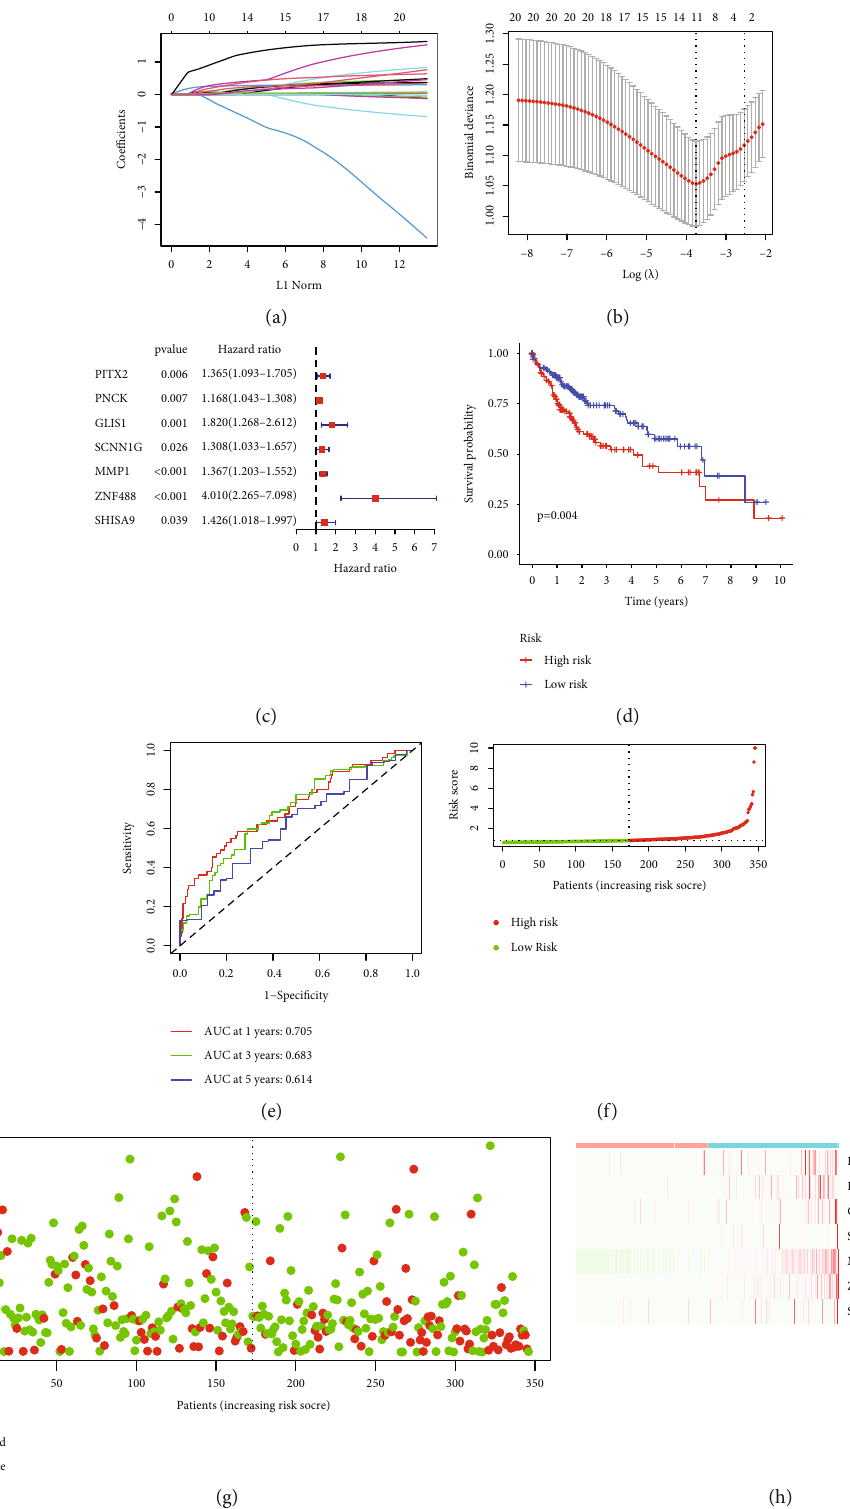
Figure 3: Establishment of a stage-related gene signature in TCGA datasets. (a) Distribution of LASSO coe ffi cients of the 21 stage-related genes. (b) The generated coe ffi cient distribution plots for the logarithmic (lambda) sequence for the selection of the best parameter (lambda). (c) Univariate assays con fi rmed 7 genes as critical prognostic genes, including PITX2, PNCK, GLIS1, SCNN1G, MMP1, ZNF488, and SHISA9. (d) Kaplan-Meier curves for overall survival. (e) The total survival risk score ’ s ability to forecast future events is supported by time-dependent receiver operating characteristic curves. (f – h) Risk score, survival time, and survival status in TCGA